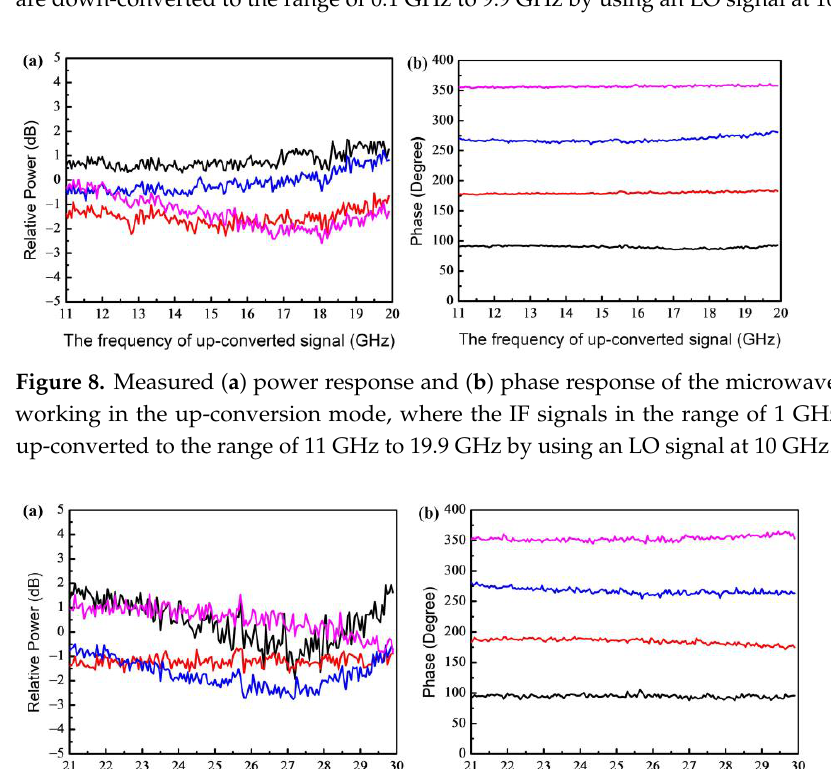
Figure 9. Measured ( a ) power response and ( b ) phase response of the microwave photonic mixer working in the up-conversion mode, where the IF signals in the range of 1 GHz to 9.9 GHz are up- converted to the range of 21 GHz to 29.9 GHz by using an LO signal at 20 GHz.